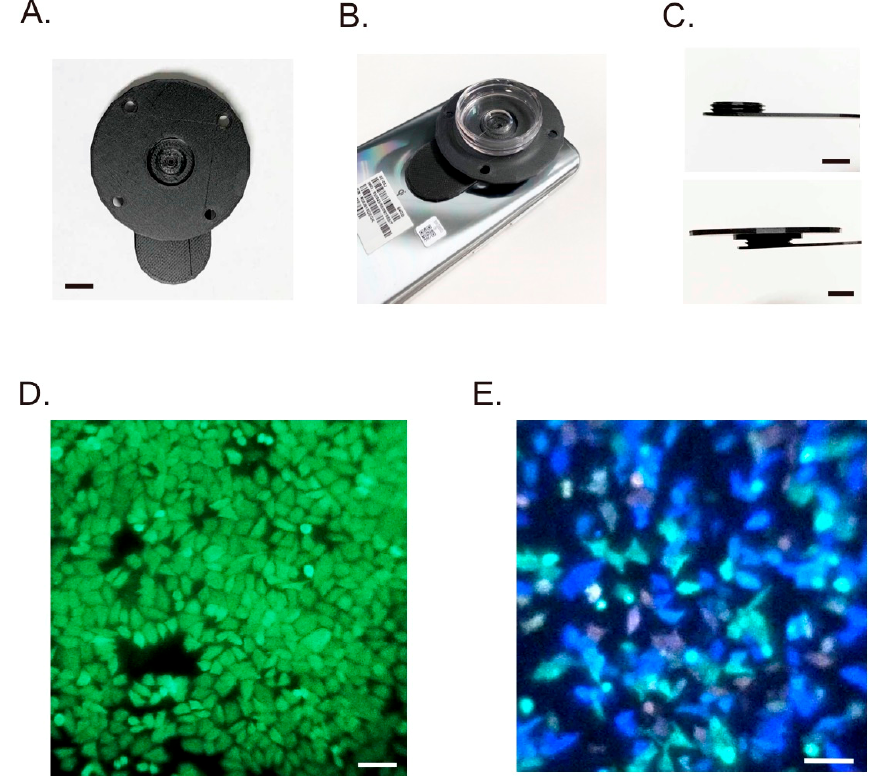
Figure 2. Bioluminescence imaging using the smartphone microscope. ( A ) Overview of the detachable objective lens. Images were taken from the front. Scale bar, 10 µm. ( B ) Attachment of the lens to the outer camera of the smartphone. ( C ) Side views of the equipment. The lens part had a screw (top), and the pedestal part was connected (bottom). The focus was adjusted by rotation of the pedestal. Scale bar, 10 mm. ( D ) Cell population imaging using the smartphone microscope. HeLa cells stably expressing yellow eNL were cultured on a dish and observed. Scale bar, 100 µm. ( E ) Population imaging of HeLa cells transiently expressing either NanoLuc or any colors of eNL (cyan, green, yellow, orange, or red). Scale bar, 100 µm.